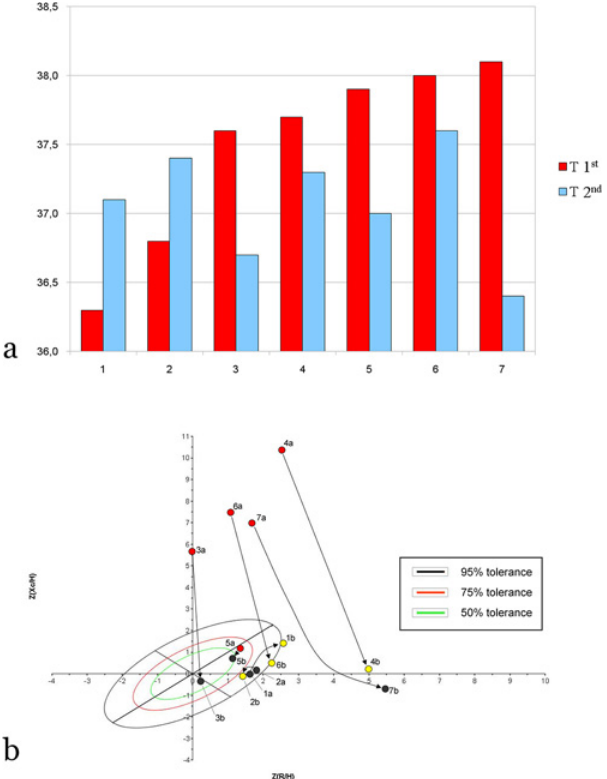
Fig 3. Changes in body temperature after 24h of Oseltamivir treatment, and bioelectrical impedance vector analysis (BIVA). Panel a: Body temperature in seven children at the time of initial BIVA (red bars) and then 24 hours after receiving the first dose of Oseltamivir (blue bars). "T 1 st " and "T 2nd ” refer to the corresponding temperatures. Children ’ s ages are: 1, 10 y; 2, 10 y; 3, 12 y; 4, 9 y; 5, 16 y; 6, 11 y; 7, 5 y. Panel b: BIVA (Z score = standardized data of paired data from children with or without fever (T (cid:1) 37.5°C, red dots; 37.1°C (cid:3) T < 37.5°C, yellow dots; T (cid:3) 37°C, black dots), with direction of arrows showing the vector migration from the initial